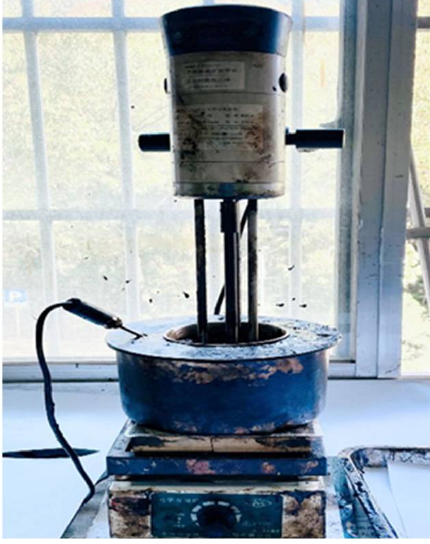
Figure 2. High-speed shear agitator for BRA-MA preparation.